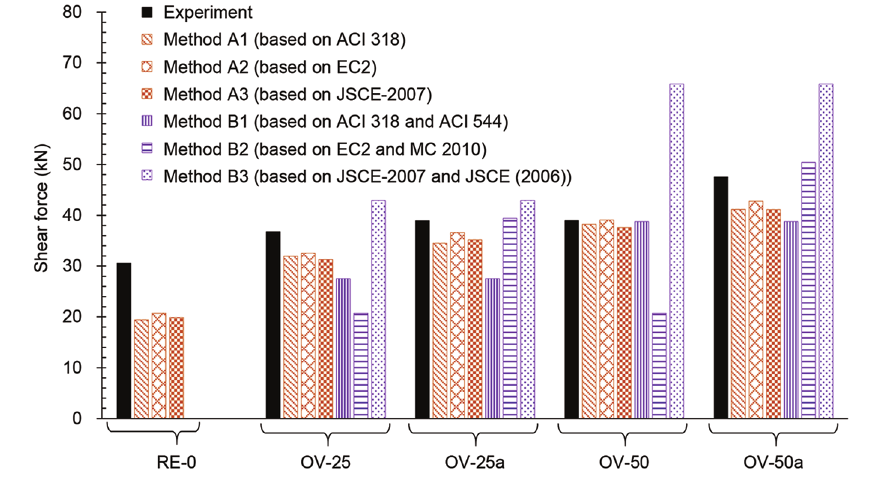
Figure 5. Shear capacities for OV series specimens (including RE-0)